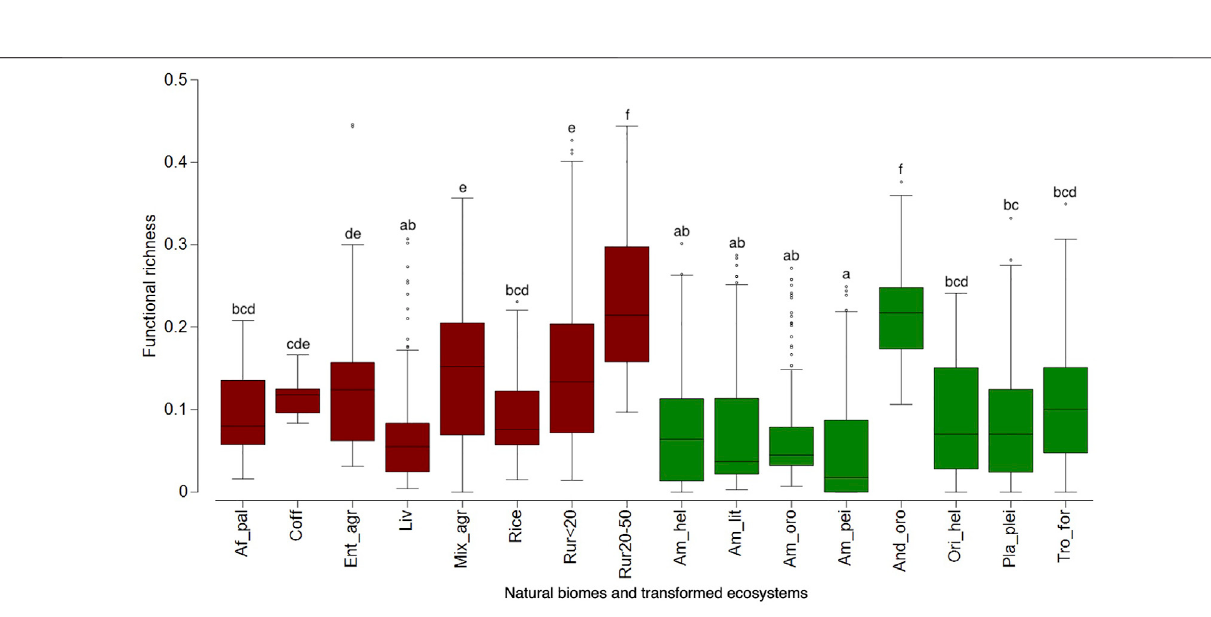
FIGURE 2 | Boxplots showing functional richness among biomes/ecosystems and land-use type (natural vs. transformed) of exotic species in the Orinoco region. Different letters indicate signi fi cant differences based on the Bonferroni test. For biomes/ecosystems see Table 1 . Red: transformed ecosystems and green: natural